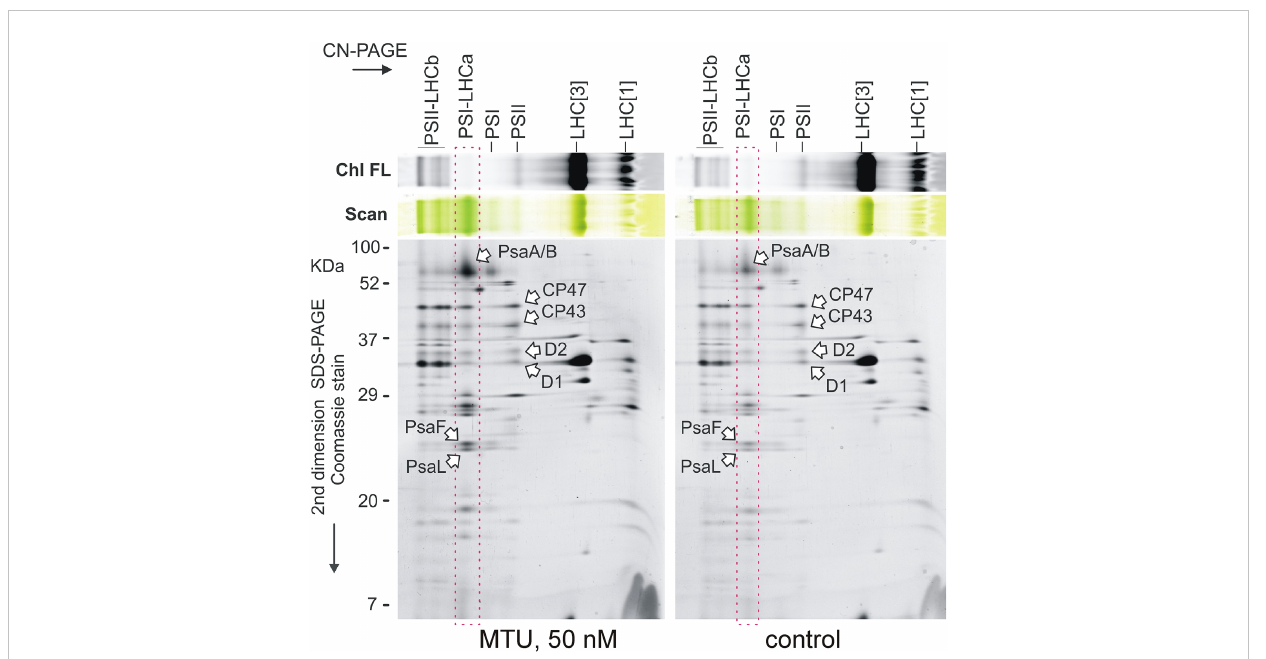
FIGURE 4 Two-dimensional gel electrophoresis of chloroplast membrane complexes isolated from fi ve 20-day-old wheat plants treated with MTU. Solubilized membranes were separated by clear-native electrophoresis (CN-PAGE) and all samples were loaded based on their chlorophyll content per dry weight. Pigmented complexes were detected in the fi rst dimension by their color (Scan) and chlorophyll fl uorescence (Chl FL). The obtained protein complexes were further separated in the second dimension on a denaturing SDS gel. PSII-LHCb, PSII supercomplexes; PSI-LHCa, Photosystem I associated with LHCa antennae; PSI, Photosystem I; PSII, Photosystem II; LHC[1] and LHC[3], monomer and trimeric light-harvesting complexes II; CP47, CP43, D2, and D1 are core subunits of PSII; PsaA/B/F/L are subunits of